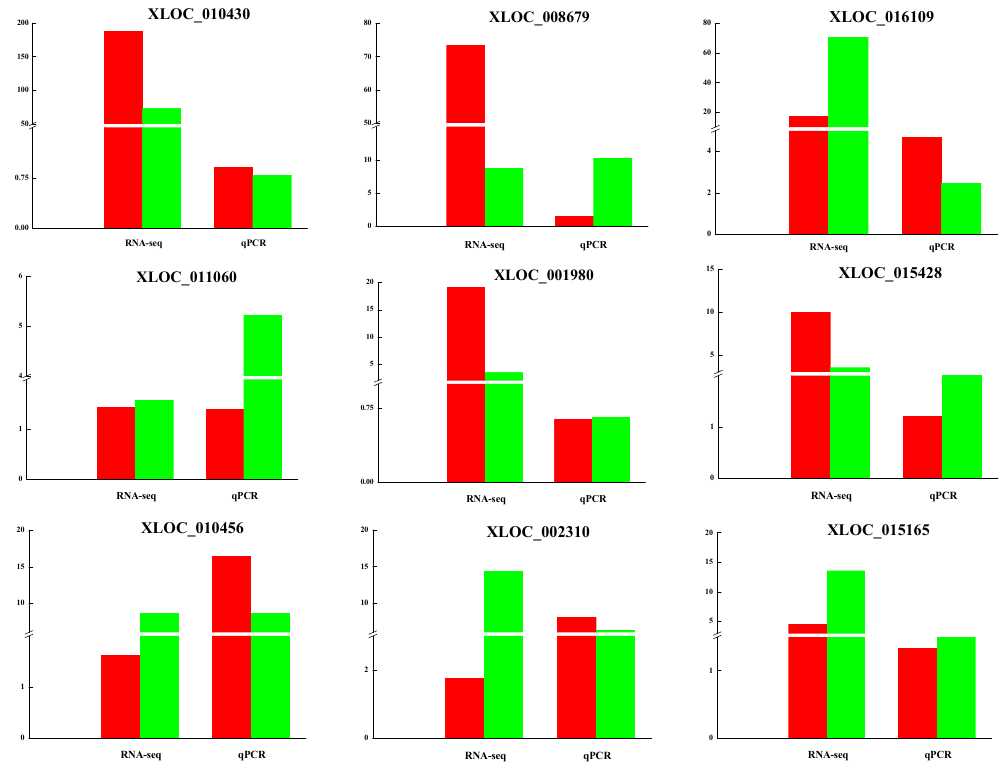
Figure 5. qRT-PCR validation of lncRNAs. RNA sequencing (RNA-seq) was used in verifying the expression of LCG and MCG, red: LCG, green: MCG. qPCR validation compared coarse-type and fine-type LCG, red: Coarse type, green: Fine type.